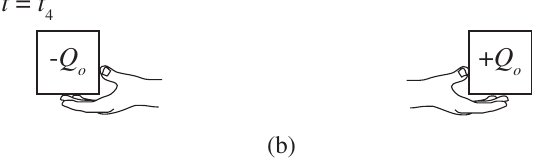
FIG. 1. The two charged blocks problem. Students were asked to identify whether potential energy was increasing, decreasing, or staying the same when (a) two like-charged blocks are pushed toward one another and (b) two oppositely charged blocks are pushed away from one another. In each case, the blocks begin and end at